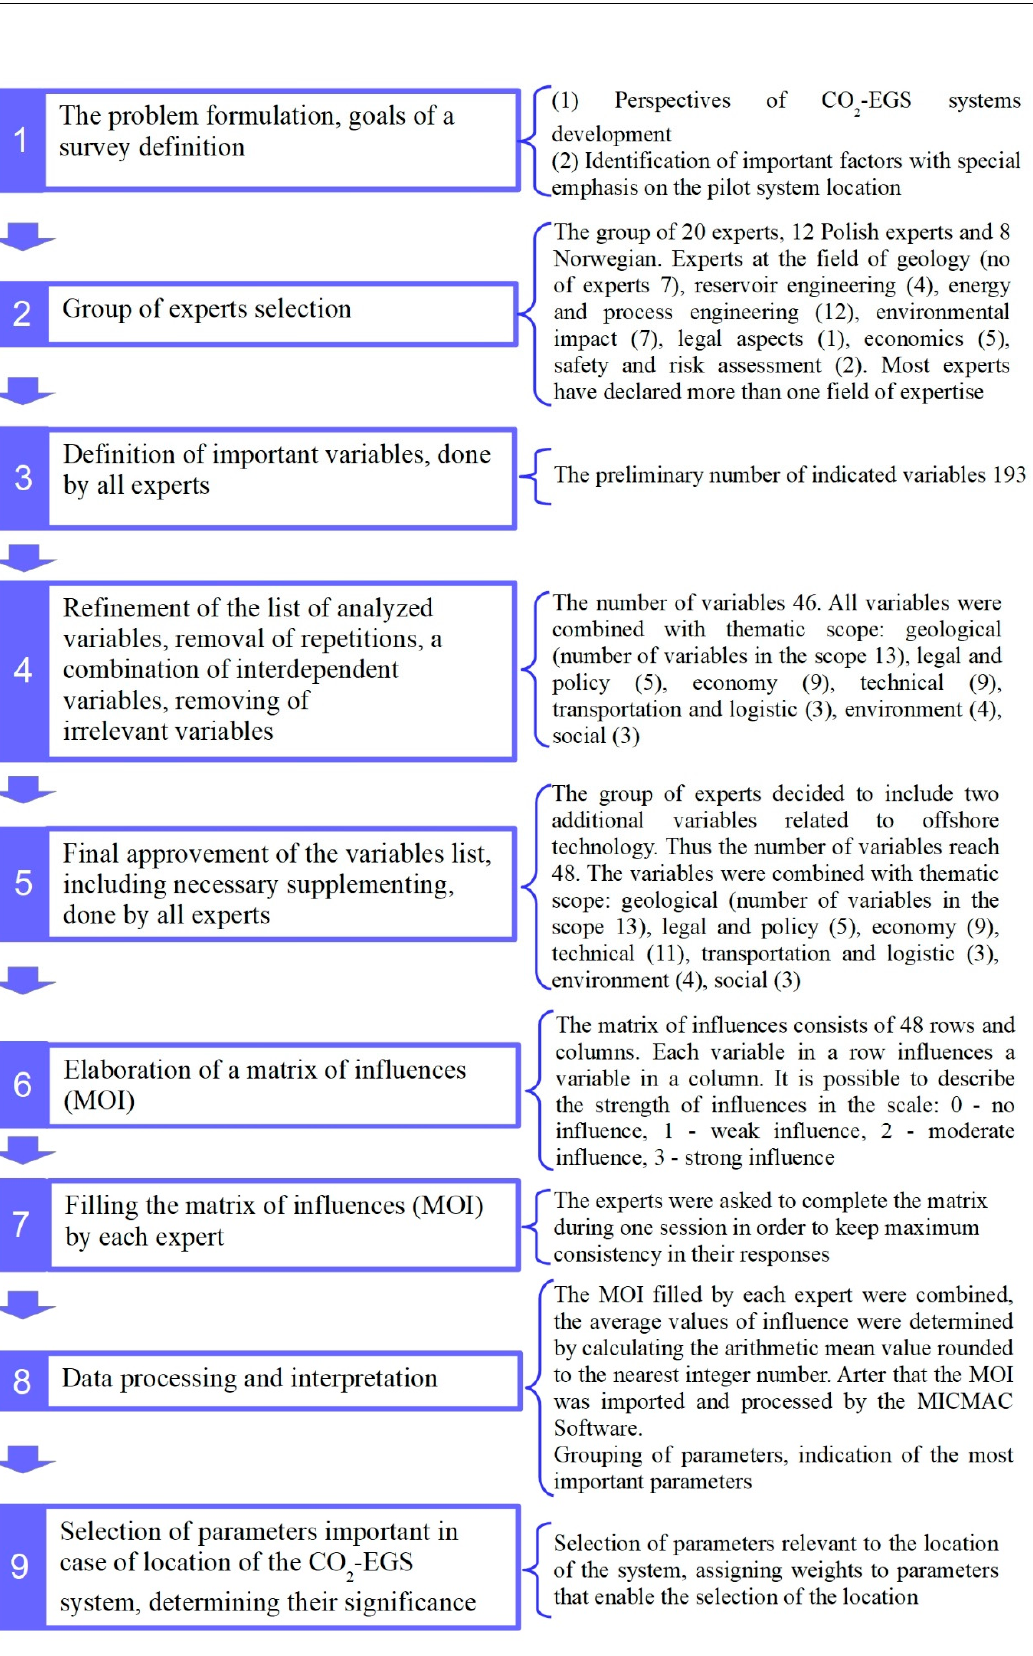
Figure 2. Description of the stages of the survey.